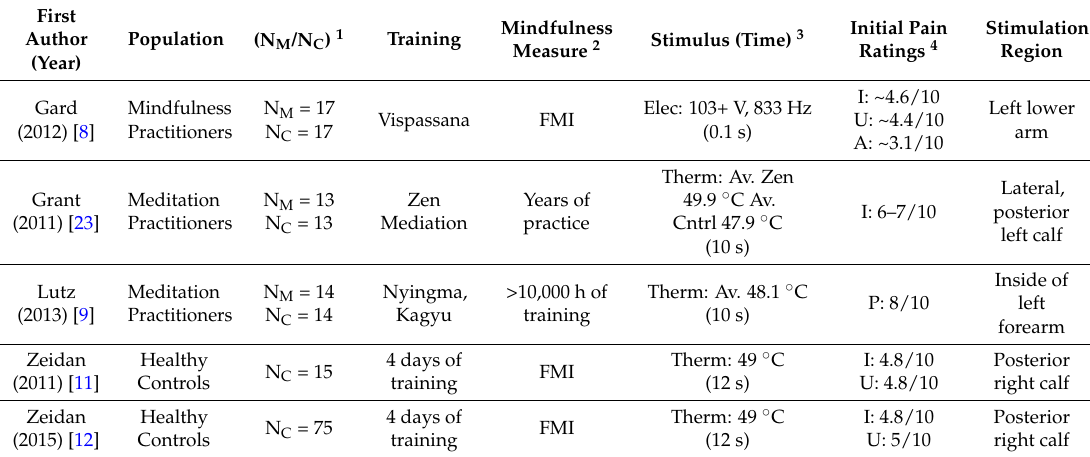
Table 1. Characteristics of the included